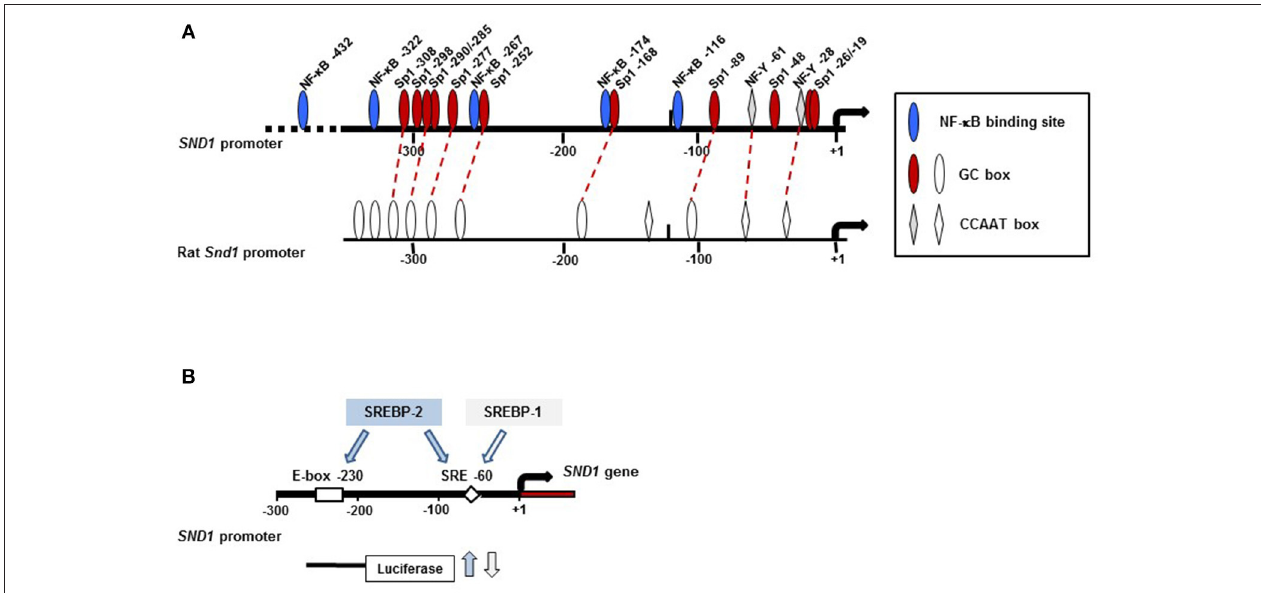
FIGURE 3 | Location of key regulatory elements of the human SND1 proximal promoter. (A) Diagram of region (-400, + 10) of the promoter. Promoter activity is under the control of the transcription factors Sp1, NF- κ B and NF-Y with 11 (GC boxes, red and white ovals), 5 (NF- κ B elements, blue ovals) and 2 (CCAAT boxes, gray and white diamonds) binding sites identified, respectively. The rat promoter conserves some of these regulatory sites. (B) Promoter activity is increased by SREBP-2 binding to E-box − 230 and/or SRE − 60 whereas it is inhibited by SREBP-1 binding to SRE − 60. The arrow indicates the transcription initiation